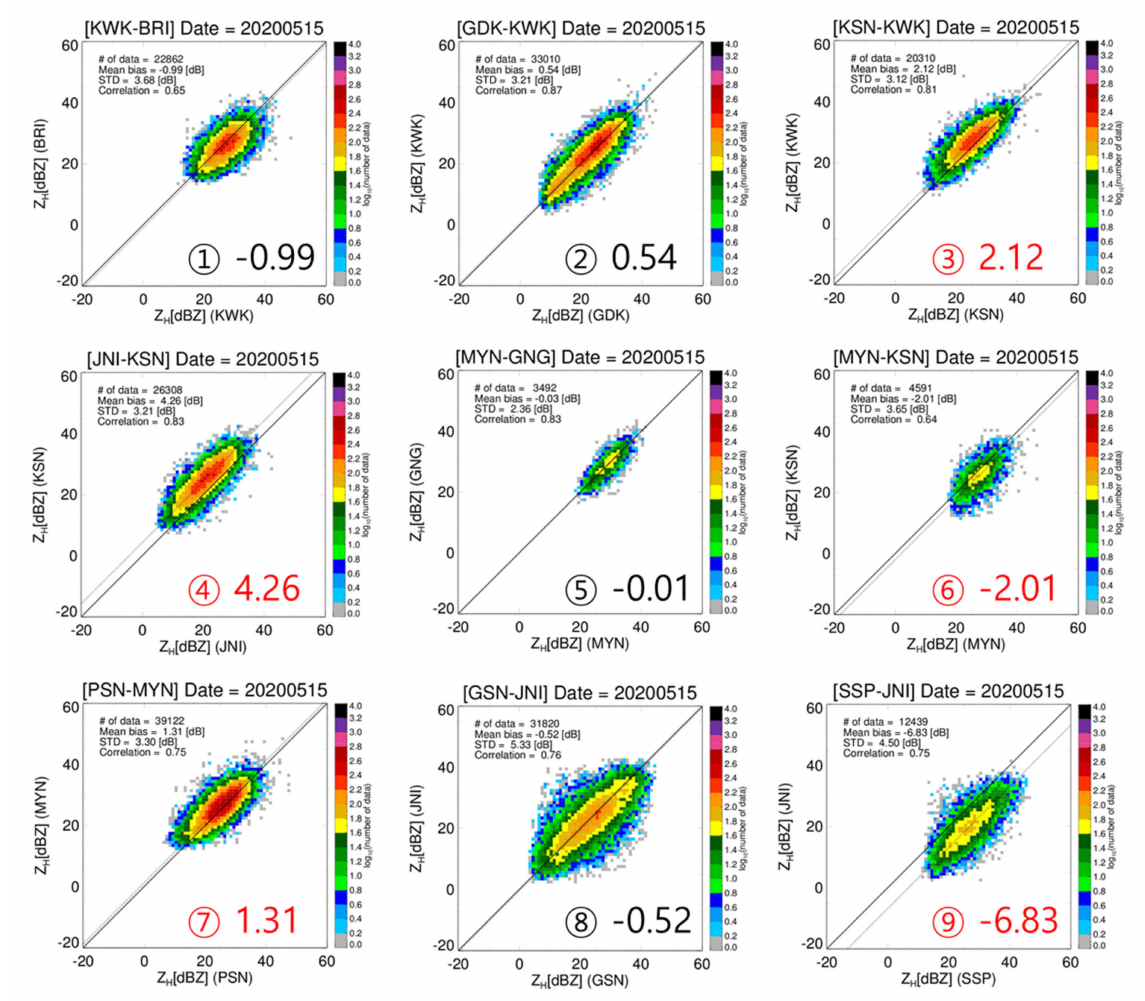
Figure 10. Scatter plots of radar reflectivity between two radars during the 15 May 2020 before calibration bias correction. The dashed line represents the mean bias of the reflectivity. The numbers from (1) to (9) correspond to the order of matched radar pairs in Table 2. The black numbers indicate the mean bias within ± 1 dB, while the red numbers indicate the mean bias out of ± 1